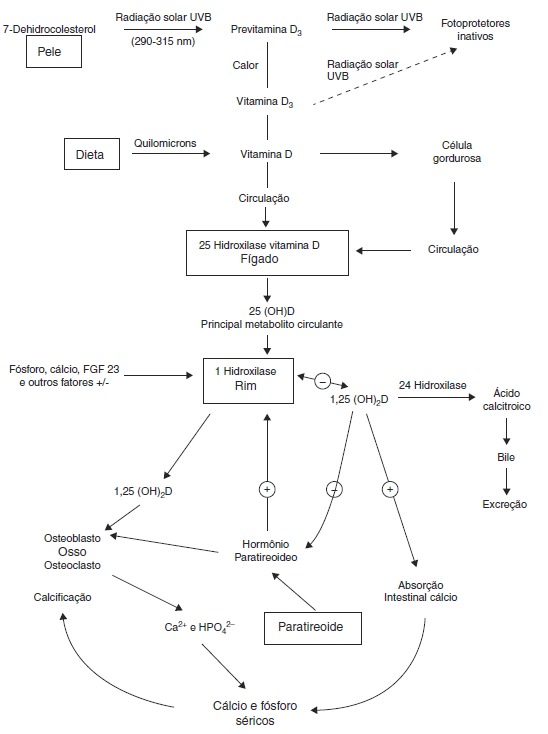
Síntese e metabolismo da vitamina D assim como sua ação na regulação dos
níveis de cálcio, fósforo e metabolismo ósseo.8 UVB, raios ultravioleta B;
25(OH)D, 25-hidroxivitamina D; 1,25(OH)2D, 1,25-di-hidroxivitamina D;
FGF-23, fator de crescimento de fibroblastos 23; Ca2+, ions cálcio; HPO42-,
íons fósforo.